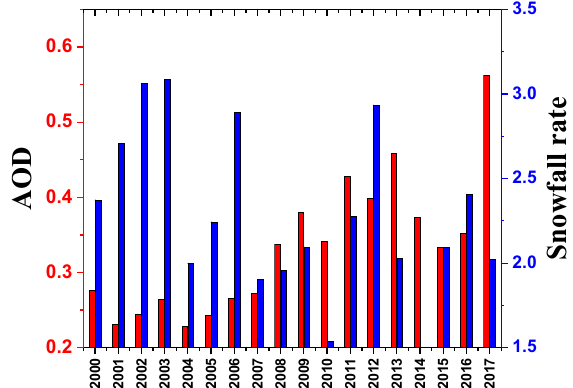
Figure 6. Time series of MODIS/Terra mean aerosol optical depth (red bars) at 550 nm (AOD 550) and mean annual snowfall rate (blue bars) in kg m − 2 s − 1 from 2000 to